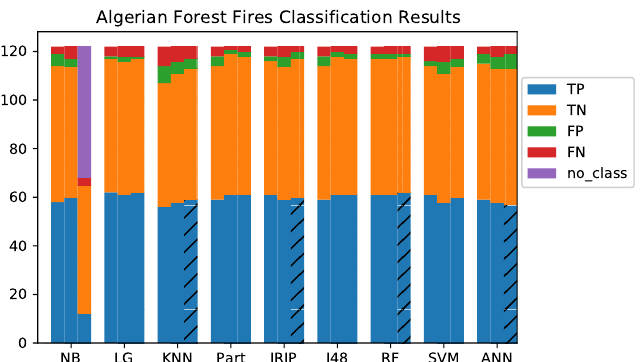
Figure A1. Graph corresponding to the Algerian Forest Fires dataset. In blue are true positives, in orange are true negatives, in green are false positives, in red are false negatives, and in purple are unclassified instances.